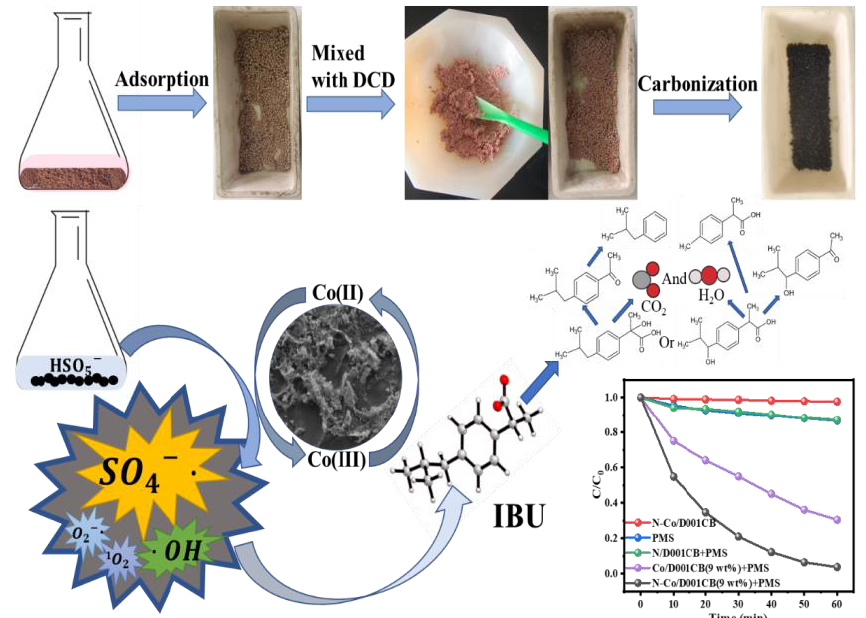
Figure 9. Roadmap for the material preparation step and the degradation process of ibuprofen by activating PMS.